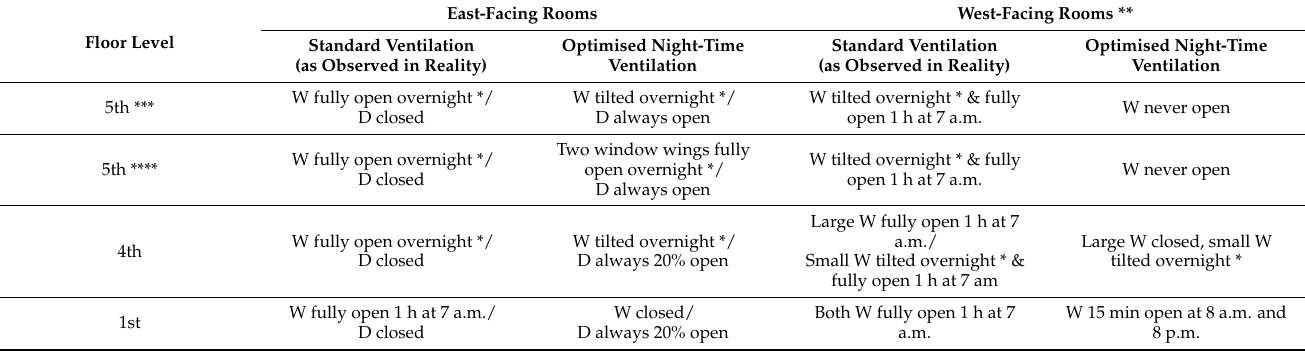
Table A2. Window (W) and room door (D) opening degree and schedule for the optimized night-time ventilation simulation scenario (results see variant d) in Figure 7) in comparison to standard window ventilation behavior used for all other simulations. Window only open in the given times if room temperature is > 22 ◦ C and outdoor temperature < room temperature). * from 8 p.m. to 8 a.m., ** wall opening, no room door present, *** dwelling 1, **** dwelling 2.